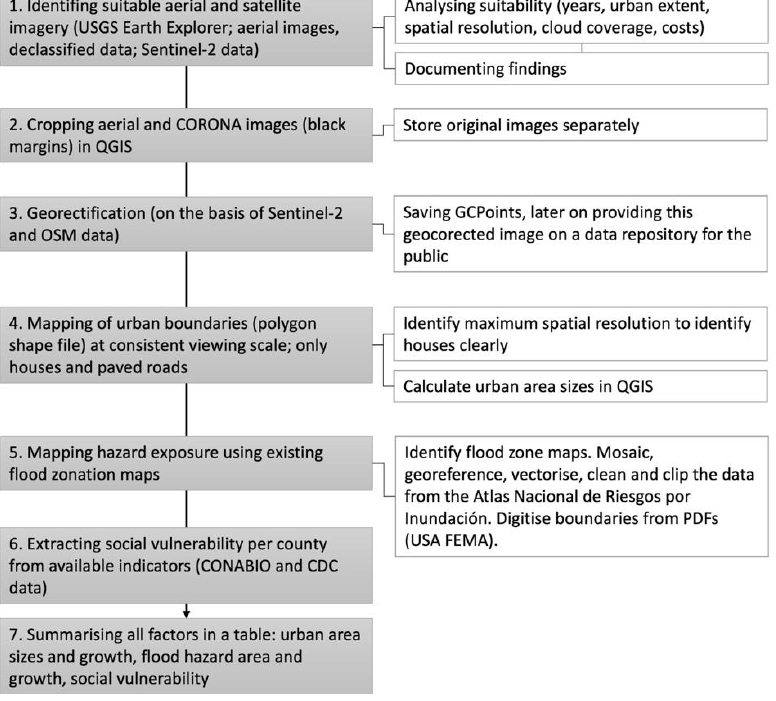
Figure 1. Flowchart of methodological steps in this article.